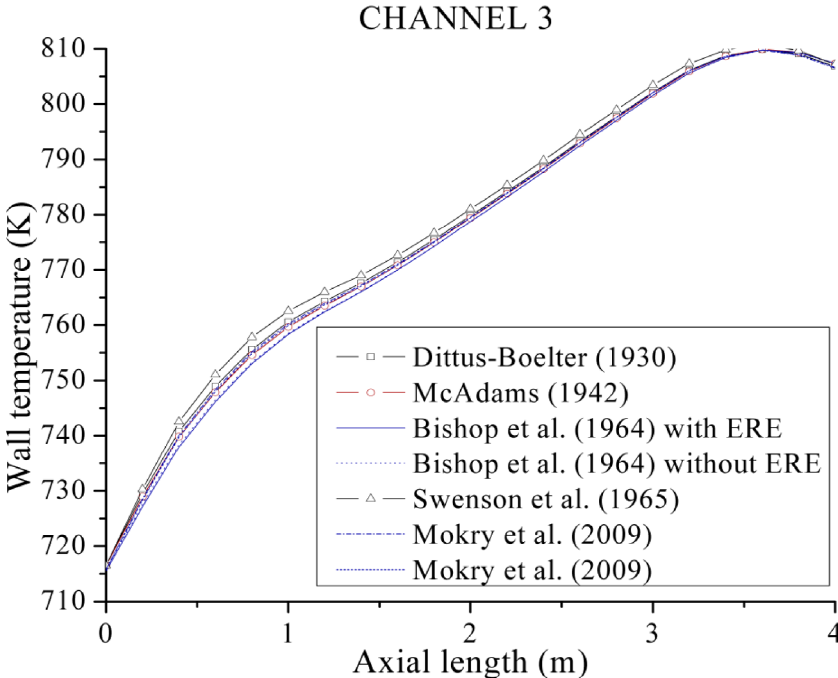
Fig. 10. Simulation results for Channel 3 showing the Wall Temperature behavior for different